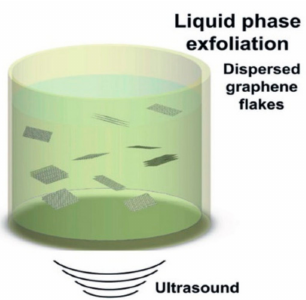
Figure 2. Liquid phase exfoliation for graphene production. Reproduced with permission from the authors of [57]. Copyright 2012,